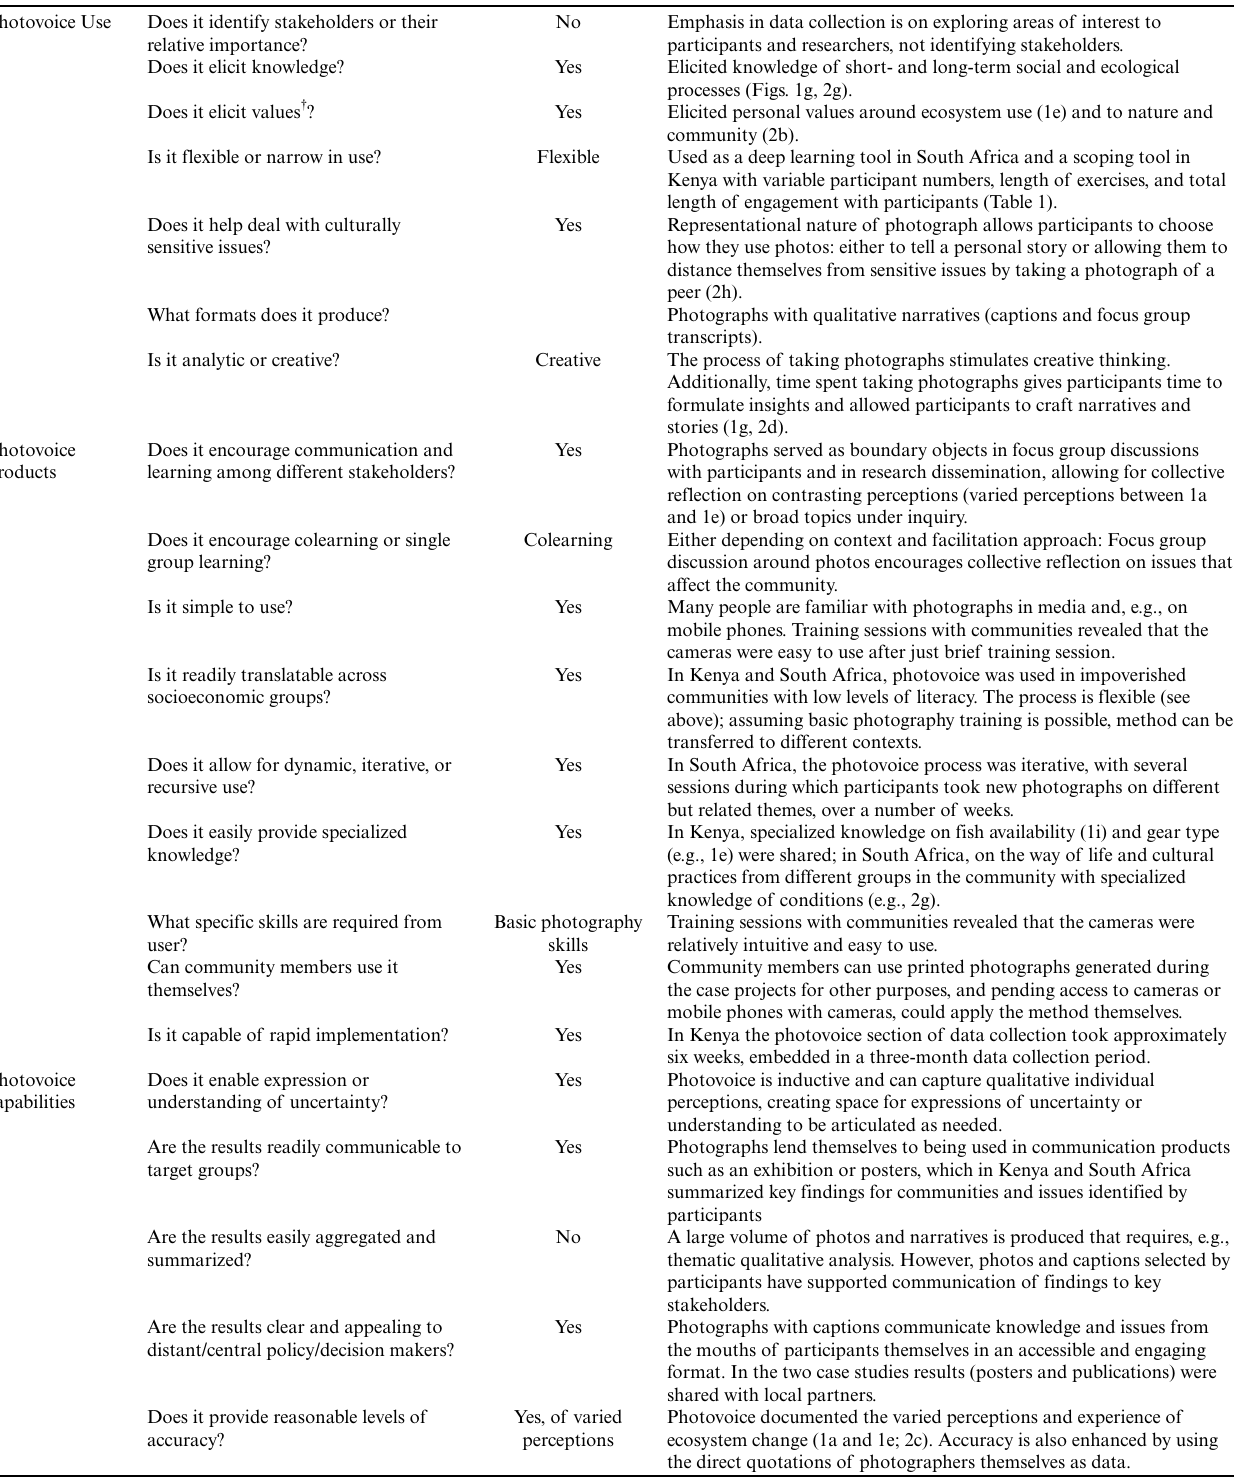
Table 2 . Evaluation of photovoice according to Lynam et al. (2007) criteria for participatory tools. Numbers in the fourth column refer to the different images in Figure 1 and 2 as